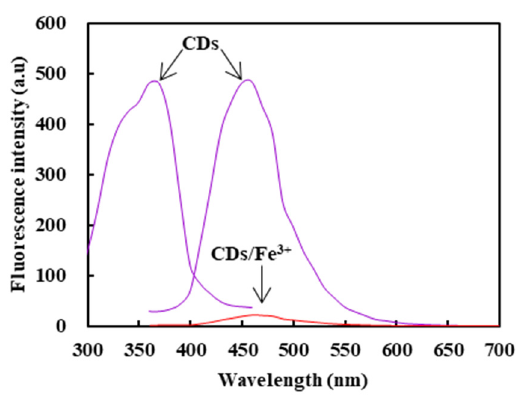
Figure 4. The UV absorption spectrogram of CDs and the CDs/Fe 3+ composite.